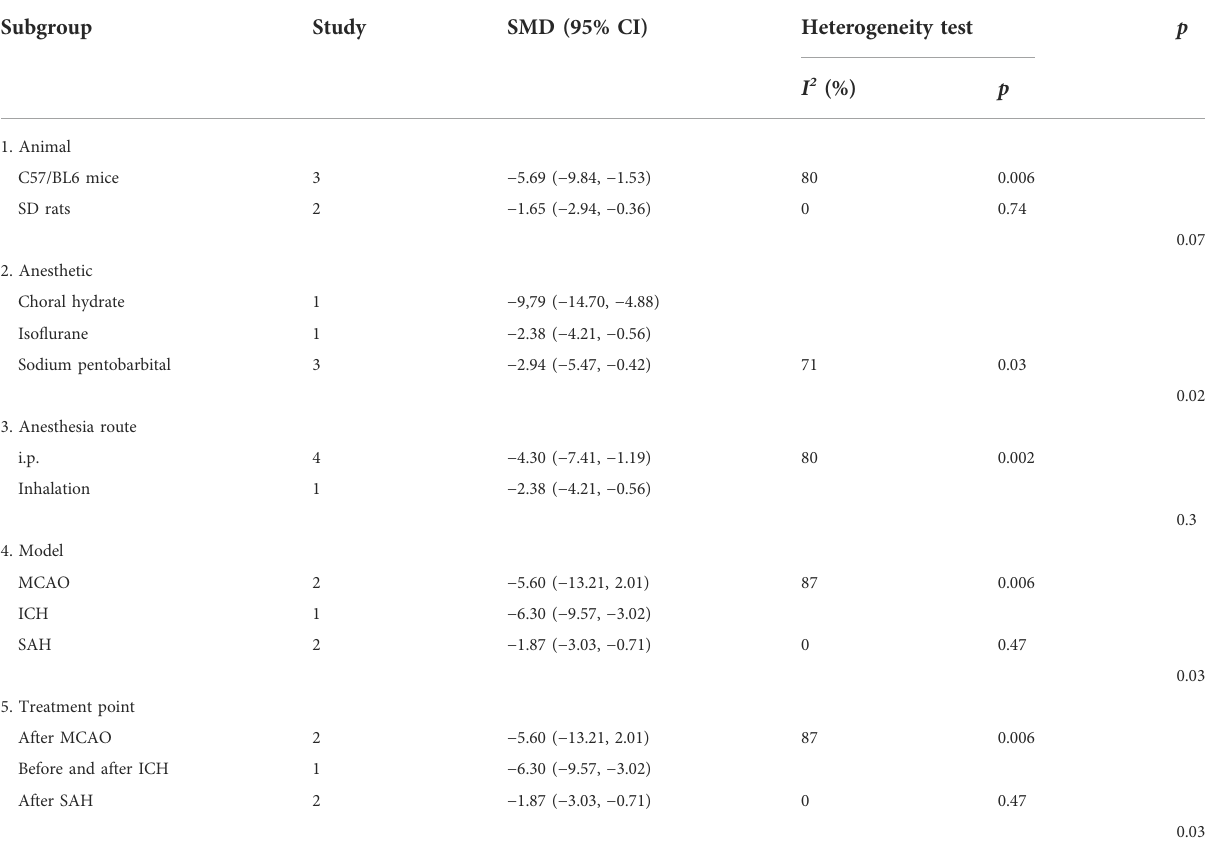
TABLE 7 Strati fi ed meta-analysis of